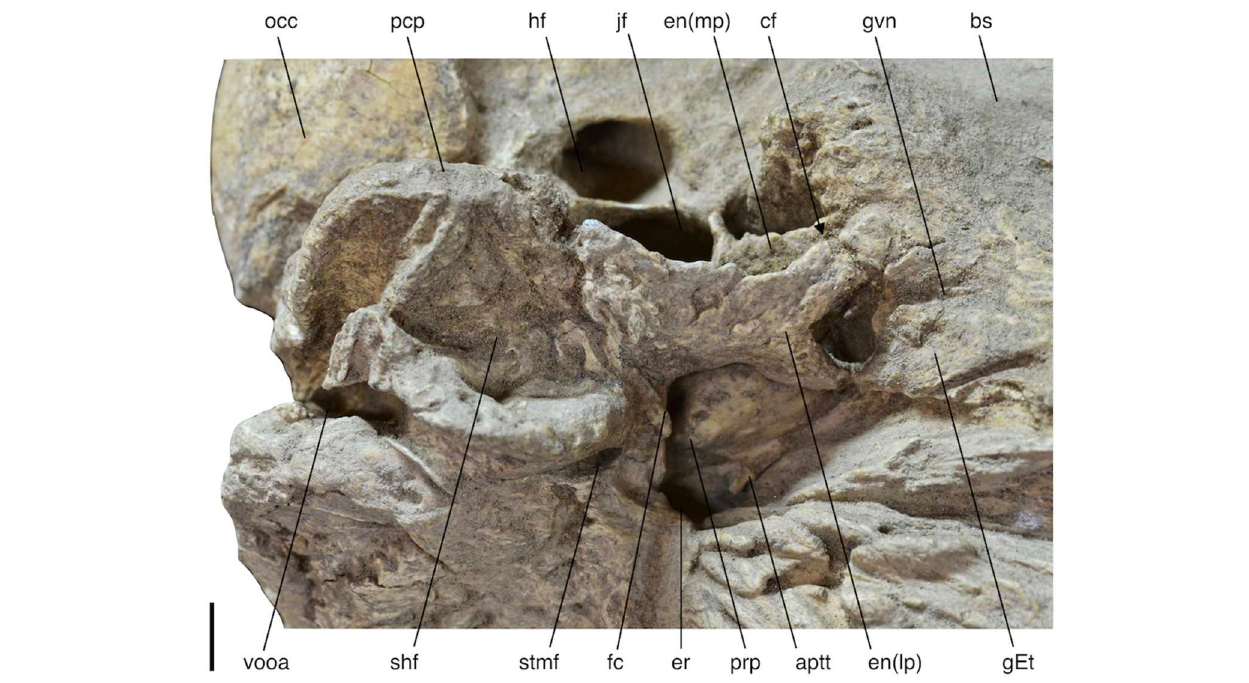
FIGURE 3 | Left ear region of Catonyx tarijensis MNHN-Bol V 13364 in ventrolateral view (anterior toward the right). aptt, anteroventral process of the tegmen tympani; bs, basisphenoid; cf, carotid foramen; en(lp), entotympanic (lateral plate); en(mp), entotympanic (medial plate); er, epitympanic recess; fc, fenestra cochleae; gEt, groove for the Eustachian tube; gvn, groove for the vidian nerve; hf, hypoglossal foramen; jf, jugular foramen; occ, occipital condyle; pcp, paracondylar process of exoccipital; prp, promontorium of petrosal; shf, stylohyal fossa; stmf, stylomastoid foramen; vooa, ventral opening for the occipital artery. Scale bar equals